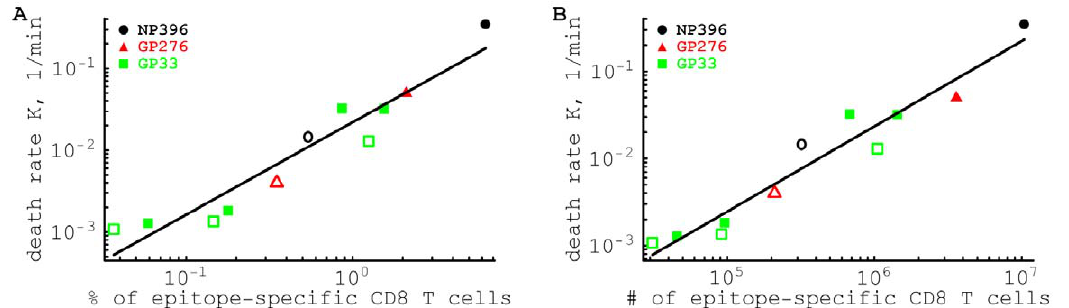
Figure 3. The estimated death rate of peptide-pulsed targets due to killing by epitope-specific CD8 + T cells is proportional to the average percent (panel A) or average number (panel B) of epitope-specific CD8 + T cells in the spleen. Note that the percent of antigen- specific CD8 z T cells is calculated among all cells in the spleen. Estimates are given for targets pulsed with NP396 ( . ), GP276 ( m ), or GP33 ( & ) peptides from LCMV. Filled symbols are for killing by effector CD8 z T cells, and open symbols are for killing by memory CD8 z T cells. Lines show the linear regression for the log { log transformed estimates of the death rate and density of CD8 z T cells. Slopes for the regressions are not statistically different from one (panel A: slope=1.13, p ~ 0 : 30 ; panel B: slope=0.98, p ~ 0 : 80 ).